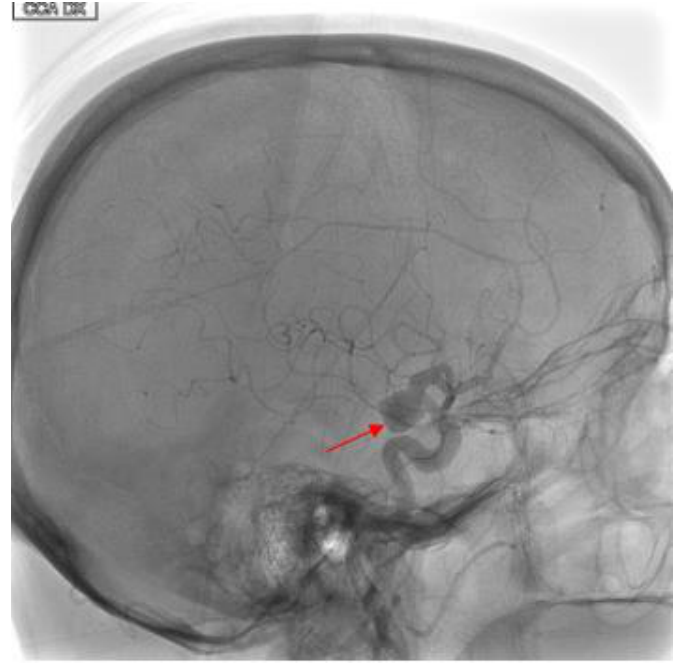
Figure 1. Eighty-year-old female with right internal carotid artery sacciform aneurysm . Findings: Latero-lateral view of digital subtracted angiography demonstrates a medium-sized, wide-necked, sacciform aneurysm artery (solid arrow) at the sovra-clinoid tract of the right internal carotid. Technique: DSA low-dose, 80Kv, 14mAs; 2 frame × second (4 s) 1 frame × second (8